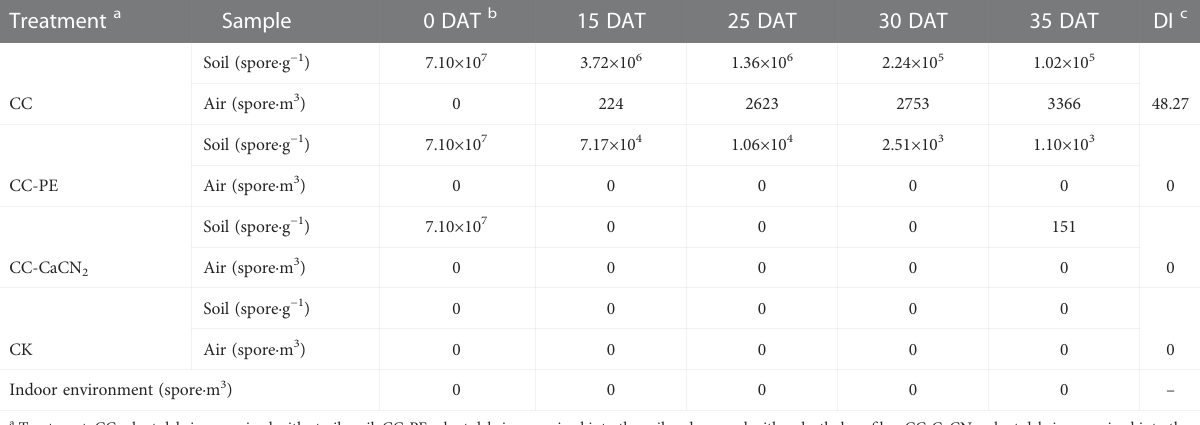
TABLE 3 The C. cassiicola content of soil and air was detected in different treatments (spore·g − 1 ). Treatment